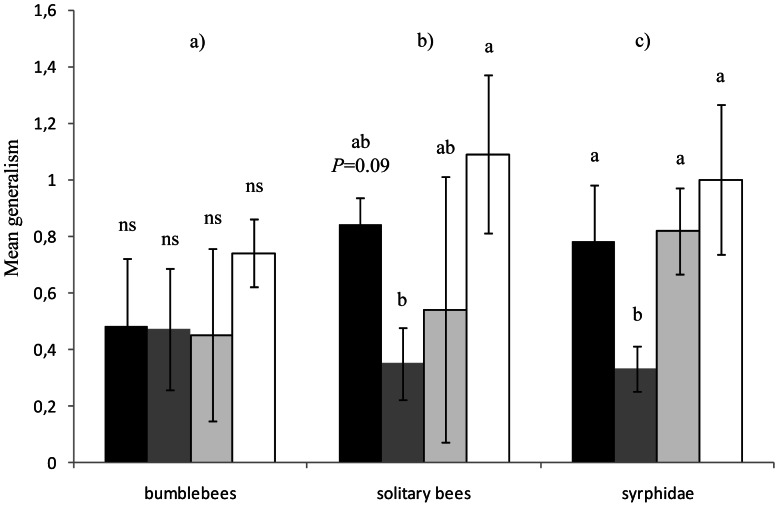
Mean weighted generalism for 3 pollinator morphotypes according to the landscape context.a) bumblebees. b) solitary bees. c) Syrphidae. Black bars: semi-natural context; dark grey bars: agricultural context; light grey bars: suburban context; white bars: urban context. Lines above bars denote 95% confidence interval. Bars that do not share the same letter show significant differences (P<0.05). NS: no significant differences (P>0.05).